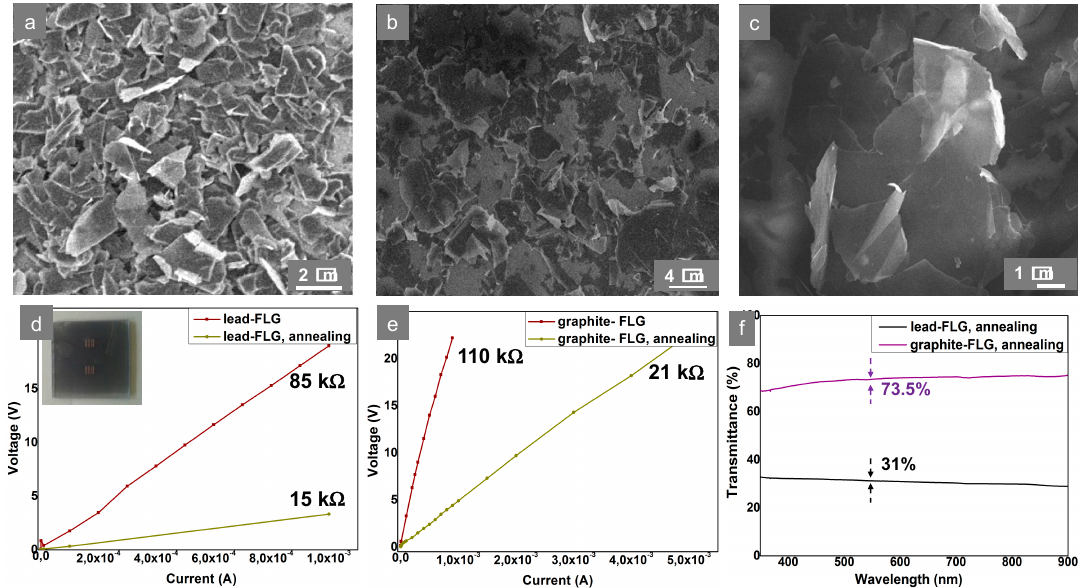
Figure 4. ( a – c ) Scanning electron microscopy (SEM) micrographs of sprayed layers: ( a ) Lead-FLG, ( b , c ) graphite-FLG; ( d , e ) I–V curves obtained by the four-point probes (FPPs) method for lead- and graphite-FLG layers (without and after annealing), respectively, and ( f ) transmittance curves of lead- and graphite-FLG layers, for comparable conductivities of the films (Rs = 15k Ω /sq and 21 k Ω /sq, respectively).